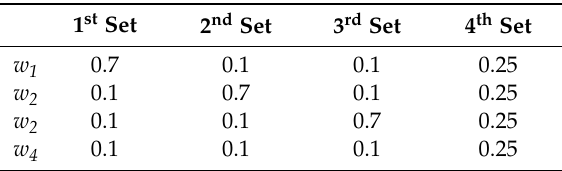
Table 3. Values of weight coe ffi